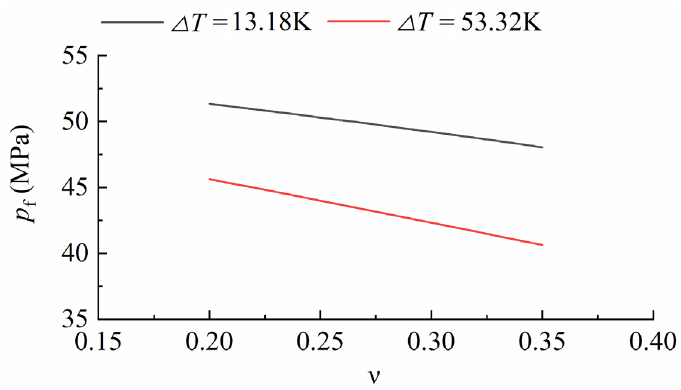
Figure 8. Effect of temperature difference between fluid and formation on initiation pressure.